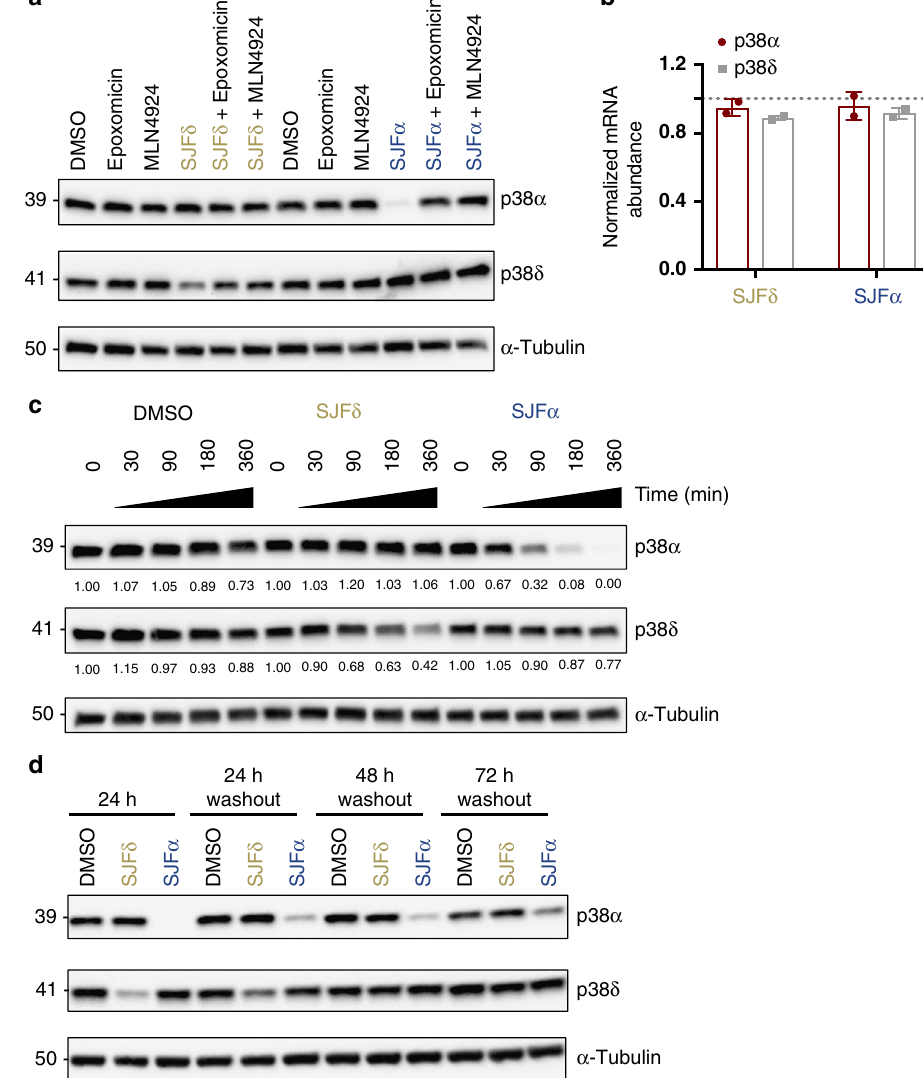
(Fig. 2b). Additionally, MDA-MB-231 cells were pre-treated with 100 µg mL − 1 of cycloheximide (CHX) and chased with 250 nM